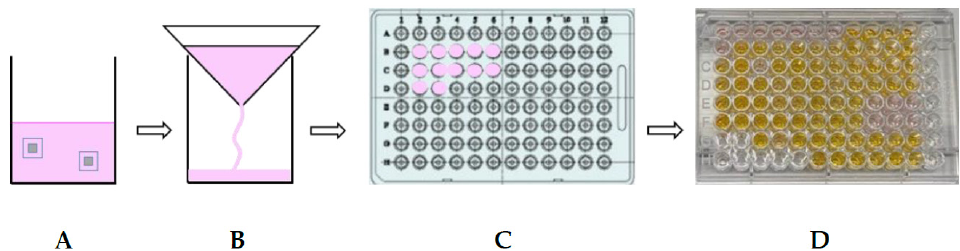
Figure 2. Protocol established for preparation of conditioned cell-culture media for further testing. ( A ) Conditioning of cell-culture media (pink) with two galinstan samples; ( B ) filtration of conditioned media; ( C ) adding the conditioned media to the cells in well plate; ( D ) color change in well plate after adding the WST-1 agent to the media right before measurement.